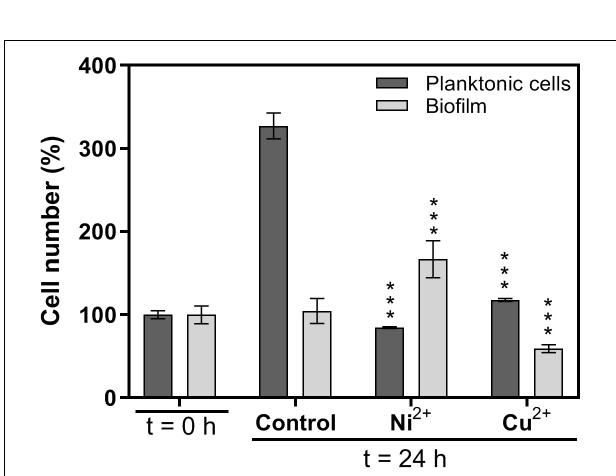
FIGURE 2 | Effects of metal ion treatment on cell numbers in planktonic cell cultures and biofilms. Biofilms were scraped from the surface and dispersed. Cell numbers in cell suspensions were determined using a counting chamber. The numbers of planktonic cells (dark bars) and biofilm cells (light bars) were determined before ( t = 0 h) and after ( t = 24 h) 24 hours incubation in the absence (control) or presence of Ni 2 + or Cu 2 + , respectively. Planktonic cells: 5 mM Cu 2 + , 15 mM Ni 2 + , biofilms: 5 mM Cu 2 + , 40 mM Ni 2 + . Planktonic cells: 100% ˆ= 2.6 ∗ 10 8 cells/mL, biofilm cells: 100% ˆ= 8.0 ∗ 10 8 cells/mL.